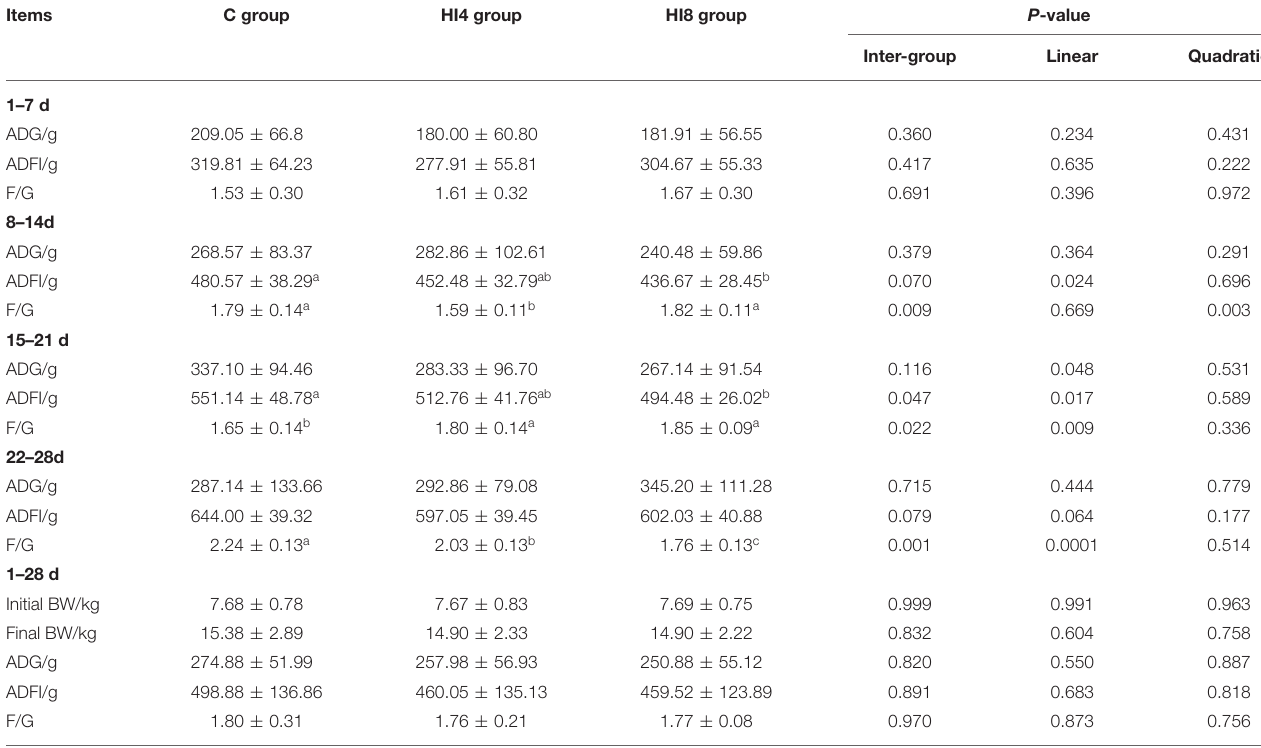
TABLE 4 | The ADG, ADFI, and F/G conditions of weaned piglets fed with different proportions of Hermetia illucens larvae for 7, 14, 21, 28 d ( n = 16).